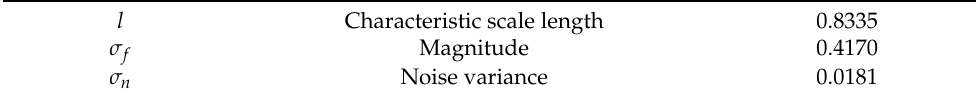
Table 2. GP-NARX hyperparameters.